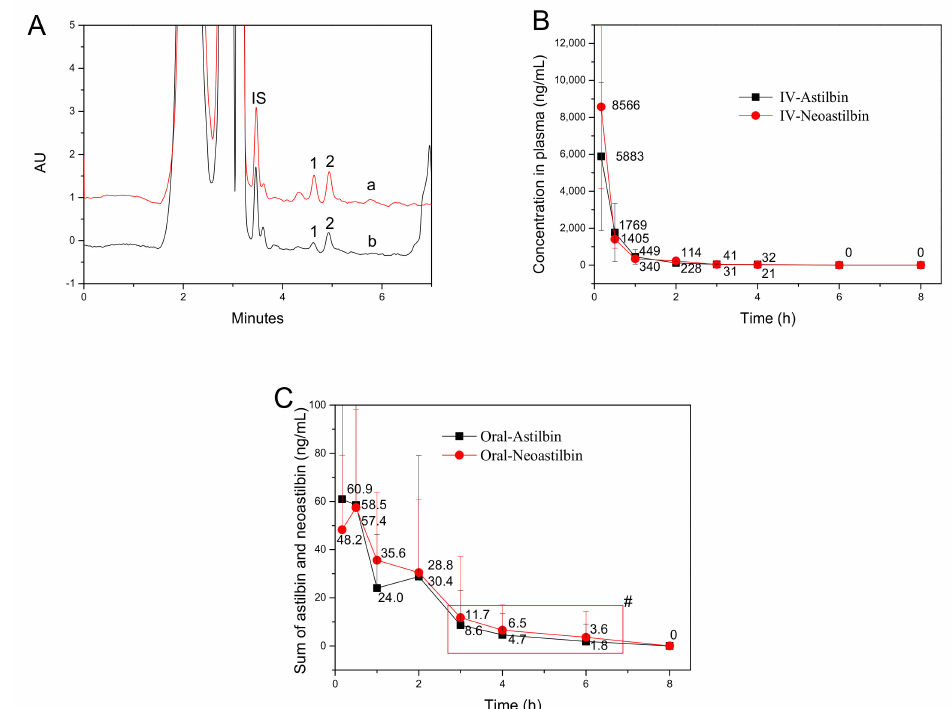
Figure 5. ( A ) Typical chromatograms of rat plasma at 30 min after oral administration of astilbin (a) and neoastilbin (b) (detected at 291 nm); ( B ) mean plasma concentration–time curves of astilbin and neoastilbin after intravenous administration (2 mg / kg) in rat. ( C ) Mean plasma concentration–time curves of astilbin and neoastilbin after oral administration of astilbin and neoastilbin suspensions (20 mg / kg) in rat; peaks: 1, neoastilbin; 2, astilbin; IS, rutin. #These data in the red box were below the lower limit of quantitation (LLOQ) of the quantified method. Hence, the accuracy of these digits was uncertain, but the presence of the flavonoid in plasma was confirmed. Table 3. The main pharmacokinetic parameters after intravenous (IV) administration (2 mg / kg) and oral administration (PO) of astilbin and neoastilbin (20 mg / kg) in rat. (n = 6).